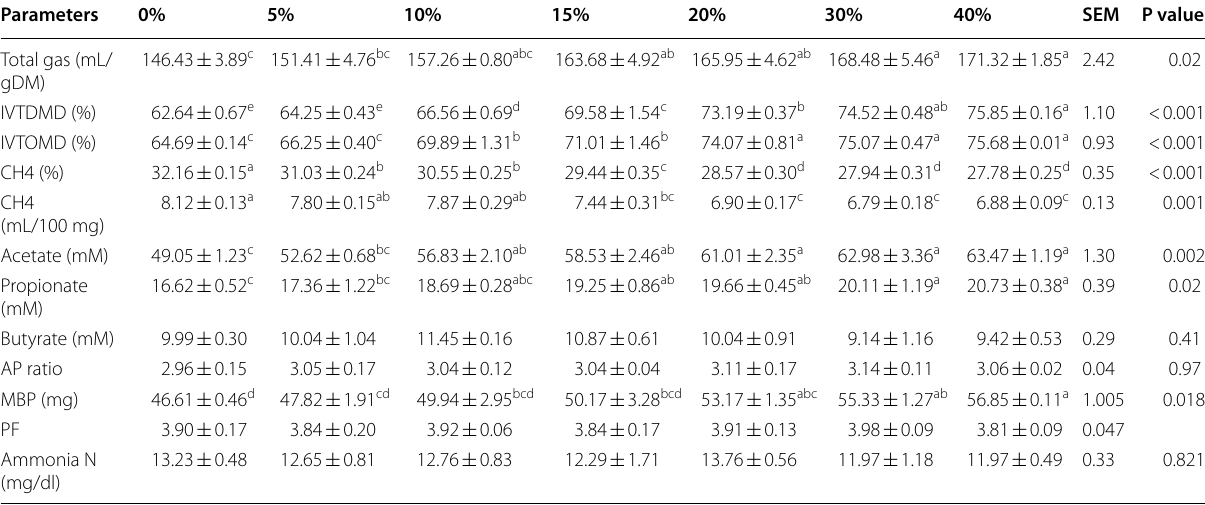
Means with different superscripts a, b, c, d and e in the same row differ significantly ( P < 0.05)